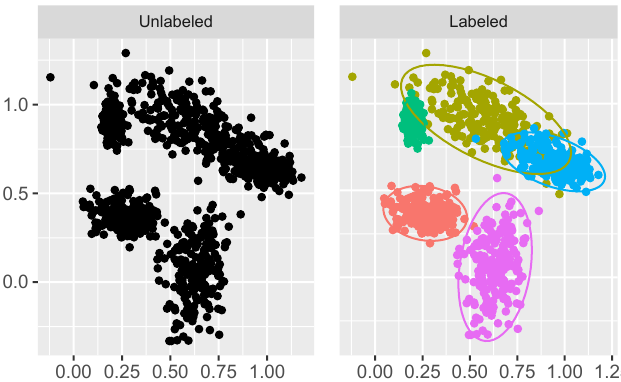
Figure 4. Simulated dataset with low overlapping